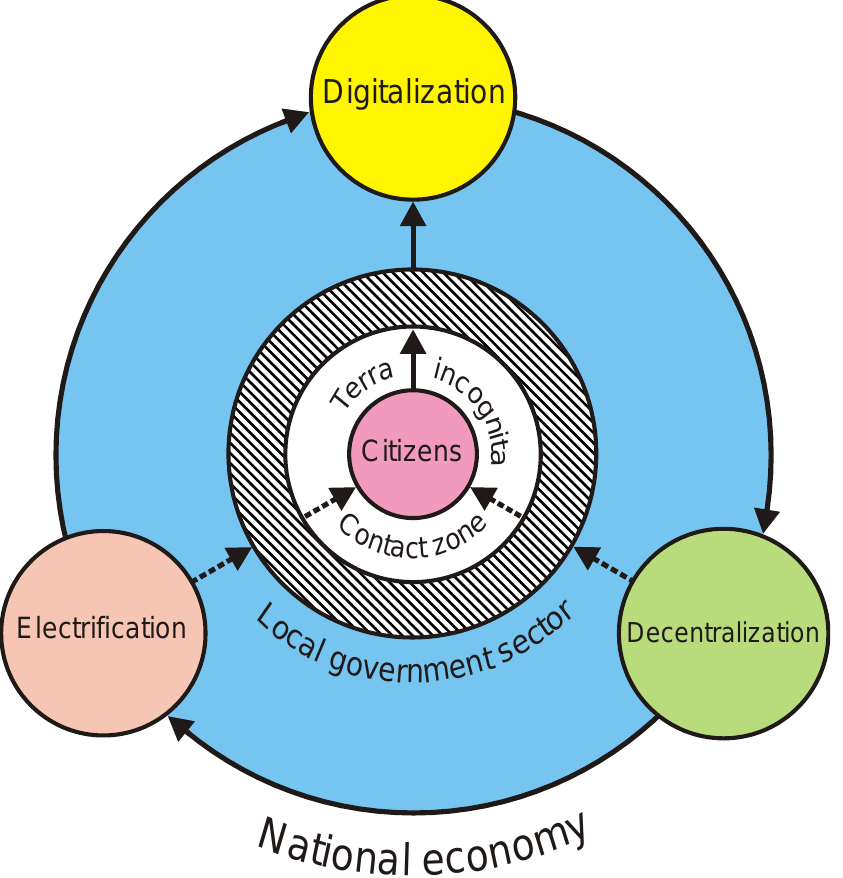
Figure 1. Forces driving the modern economy. The influence of citizens (middle class) on public administration causes the introduction of digital prosumption into this sector, which initiates a virtuous cycle involving digitalization, decentralization, and electrification. As indicated by the arrows in Figure 1, the influence of citizens on energy